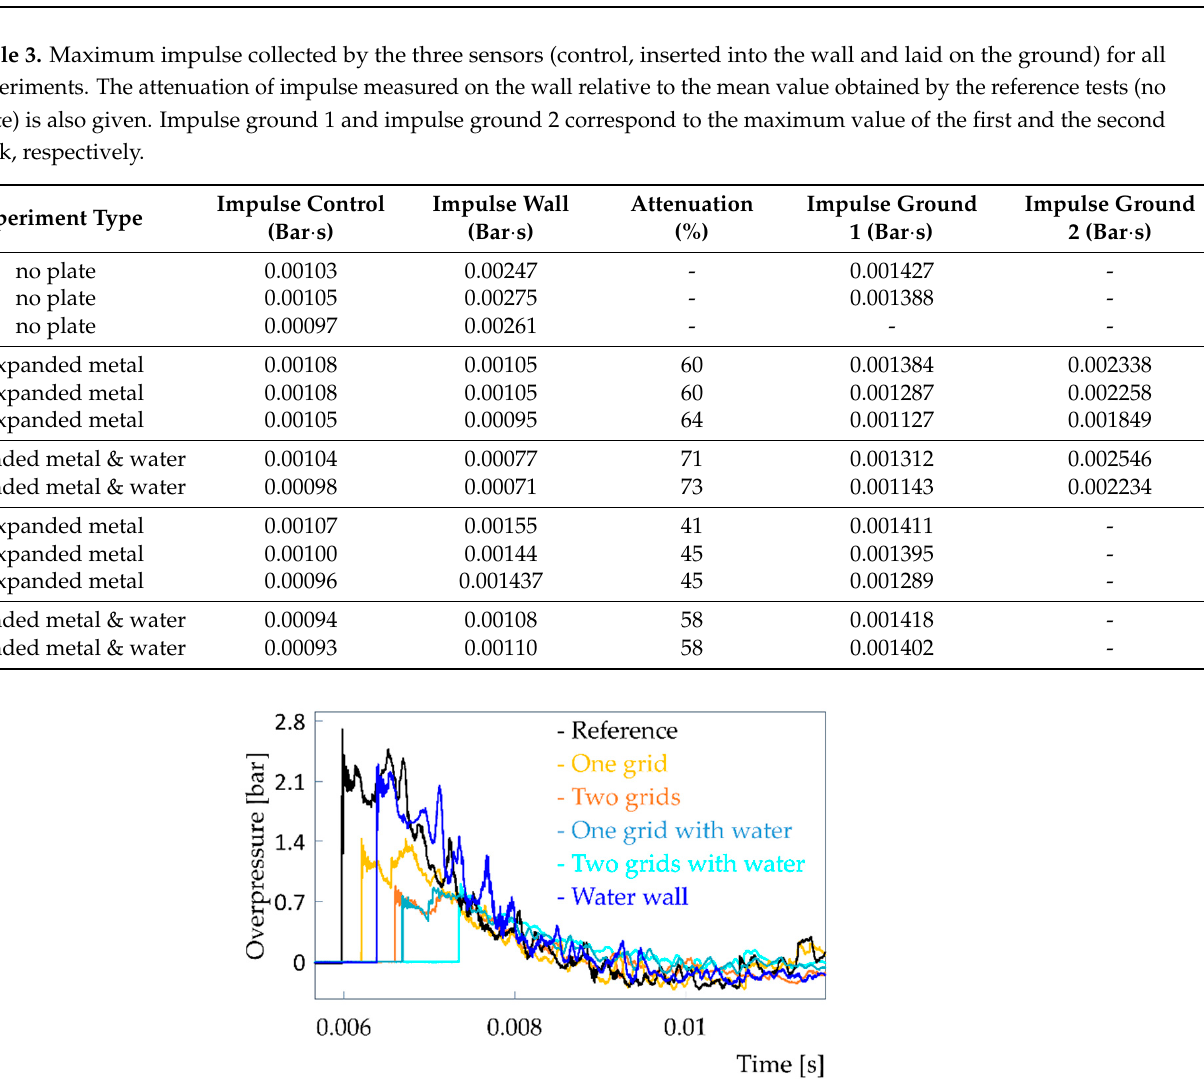
Figure 14. Reflected impulse measured on the wall for one test of each configuration. One reference test is also shown. Figure 15 presents the overpressure measured by the gauge positioned on the ground at the first plate’s position. The reflection of the shock wave, when a plate was placed near this sensor (two-plate configuration), could be observed (see the arrows in the Figure 15). In case of one-plate configurations, the sensor was placed further off the plate and the shock wave reflection was not perceptible. In the case of two-plate configurations, the re- flection of the shock wave on the second plate was clearly manifested as a huge overpres- sure second peak. Figure 15. Overpressure obtained by the gauge laid on the ground for one test of each configuration. One reference test is also shown. 4. Discussion